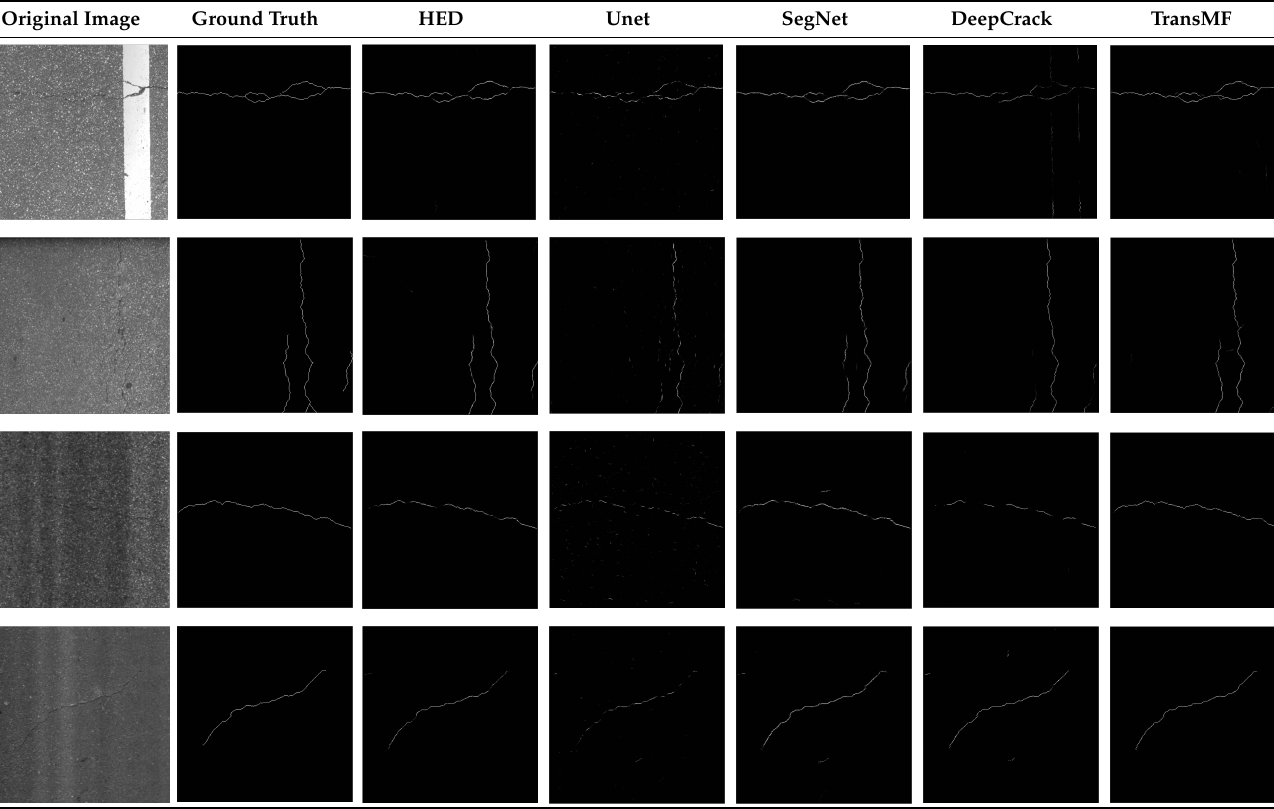
Table 6. Visualization of original and predicted segmentation images by all the